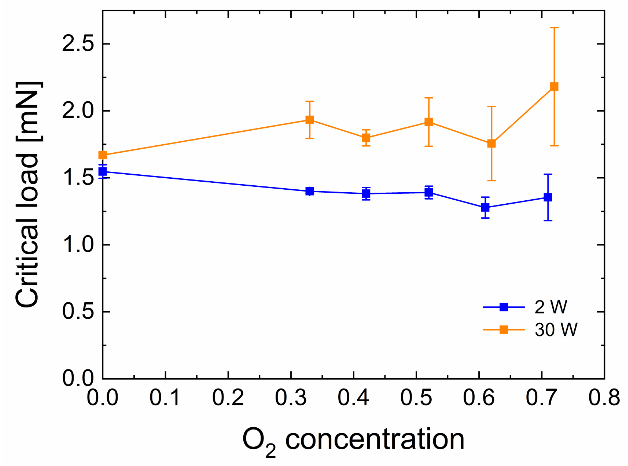
Figure 1. Dependence of the critical normal load vs. oxygen concentration for samples prepared at two different powers (2 and 30 W).